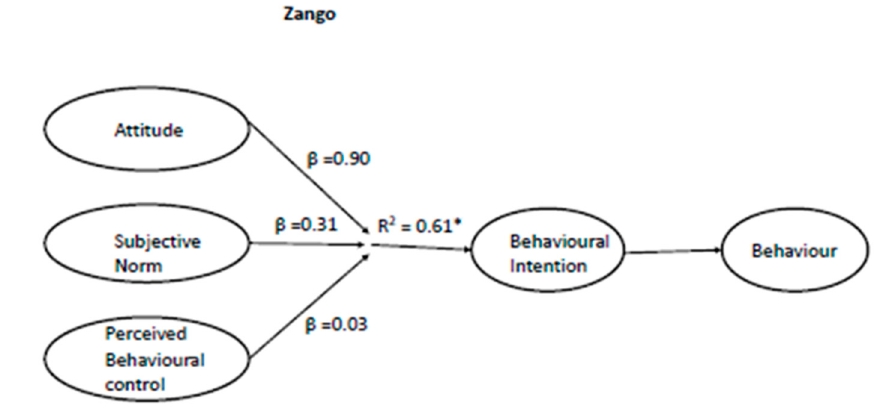
Figure 8. Theory of planned behaviour model for climate change adaptation determinants for the Zango community (* p < 0.05).